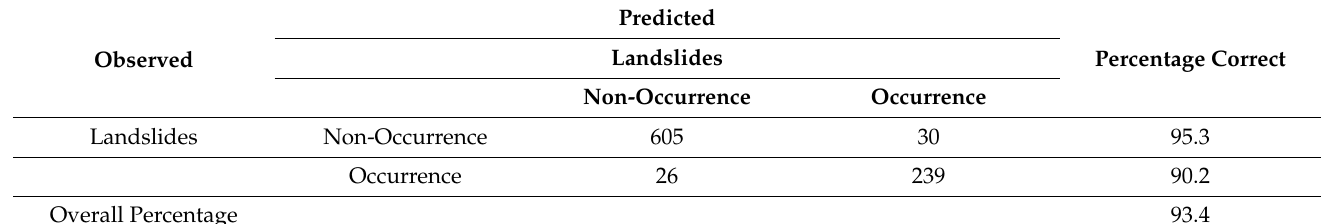
Table 4. Classification